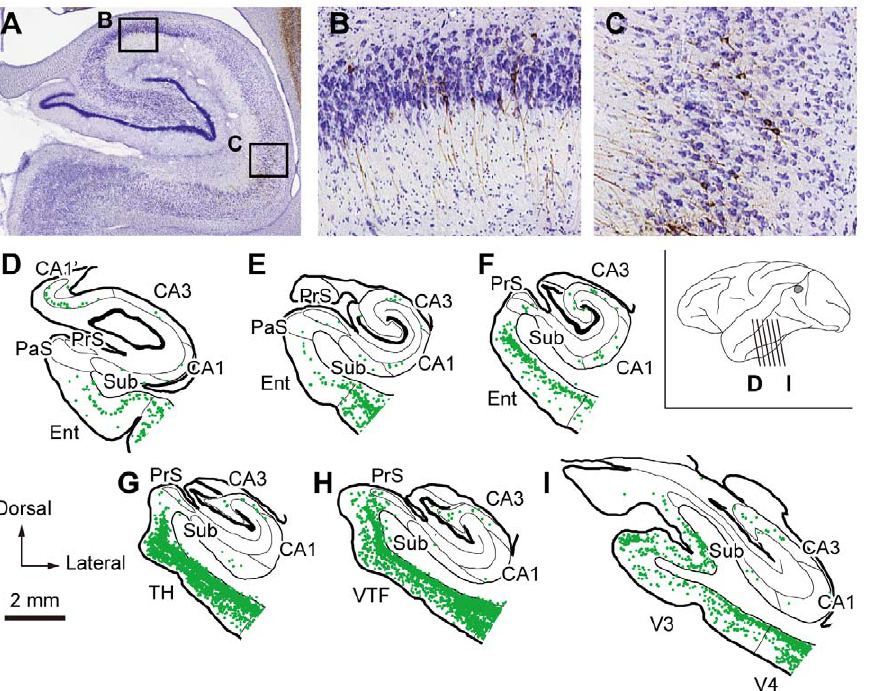
Figure 2. Distribution of retrograde labeling in the MTL 4 days after rabies injections into V4. A , Photomicrograph of rabies-labeled neurons in the hippocampal formation, counterstained with Cresyl violet. B, C , Higher-magnification images of the labeled neurons (brown) in CA3 (B) and CA1 (C), taken from the rectangular areas in A. D–I , Six representative coronal sections through the hippocampal formation in monkey V4-4b are arranged anteroposteriorly. PaS, parasubiculum; PrS, presubiculum; Sub, subiculum; V3, visual area 3; VTF, visually responsive TF. Other conventions and abbreviations are as in Figure 1.